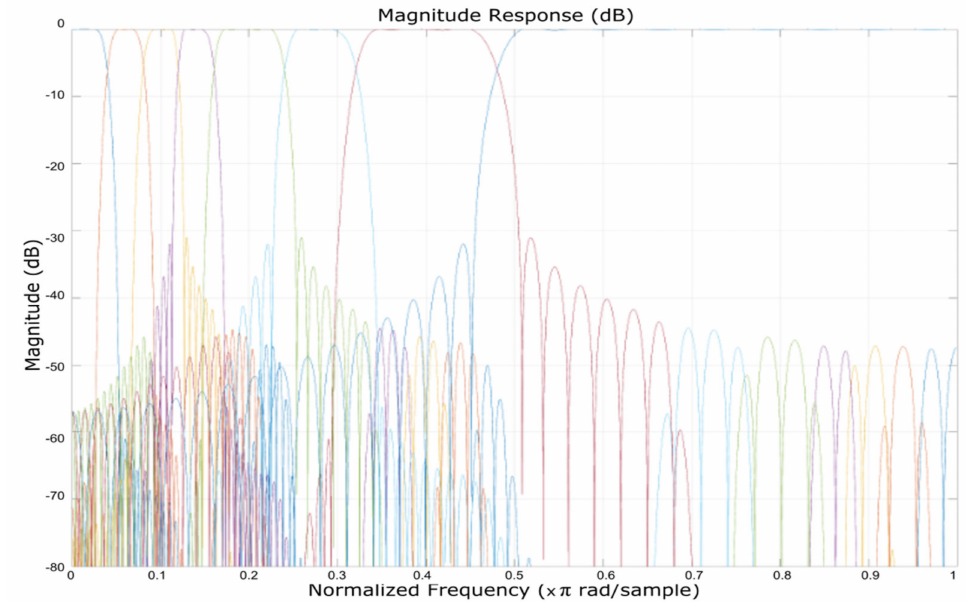
Figure 4. Magnitude response of the eight FIR filtered banks, which also displays the banks separation (the filter was applied in a cascade to each frequency